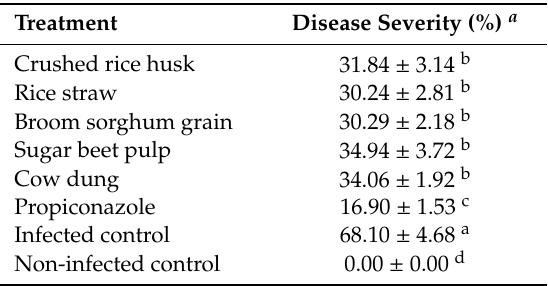
Table 2. Efficacy of different organic substrates containing Trichoderma harzianum AS12-2 in Table 2. E ffi cacy of di ff erent organic substrates containing Trichoderma harzianum AS12-2 in controlling controlling rice sheath blight in the greenhouse. rice sheath blight in the greenhouse.